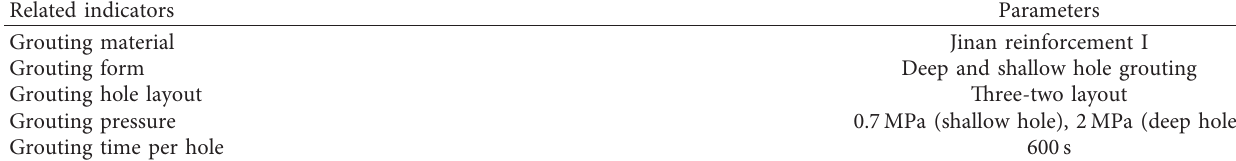
Table 5: The details of the grouting